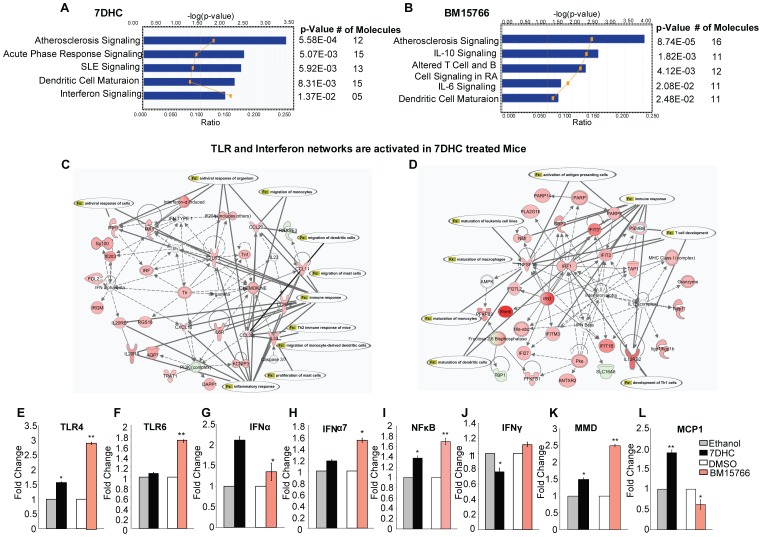
Inflammatory pathways and networks activated in C57BL/6J mouse skin after topical treatment with 7-DHC and BM15766.(A) The most significant signaling pathways altered by 7-DHC treatment participated in the inflammatory and immune responses and were identified using IPA. Fisher’s exact test was used to calculate p values to determine the probability that the association between the genes in the dataset and the pathway could be explained by chance alone. The yellow line indicates the threshold of significance (p<0.05) and represents the ratio of the number of molecules from the data set that map to the pathway to the total number of molecules that map to the pathway. (B) The top differentially regulated pathways in BM15766-treated mouse skin. The majority of the upregulated pathways participated in the inflammatory and immune responses. (C, D) The top two predicted networks in 7DHC-treated mouse skin, determined using IPA. The TLR4 and IFN gene networks are significantly upregulated by 7-DHC. Solid lines denote direct relationships between genes. Dotted lines denote an indirect relationship between two genes. A red node denotes an upregulated gene, and a green node denotes a downregulated gene. See also Table S4. Real-time PCR validation of (E) TLR4, (F) TLR6, (G) IFNα, (H) IFNα7, (I) NFkB, (J) IFNγ, (K) MMD and (L) MCP1 gene expression in mouse skin treated with 7-DHC or BM15766 compared with vehicle-treated (ethanol or DMSO) controls (n = 3; *p<0.05, **p<0.01). The unpaired t-test was used for the statistical analysis. Treatment with 7-DHC and BM15766 can induce the expression of some or all of these genes.